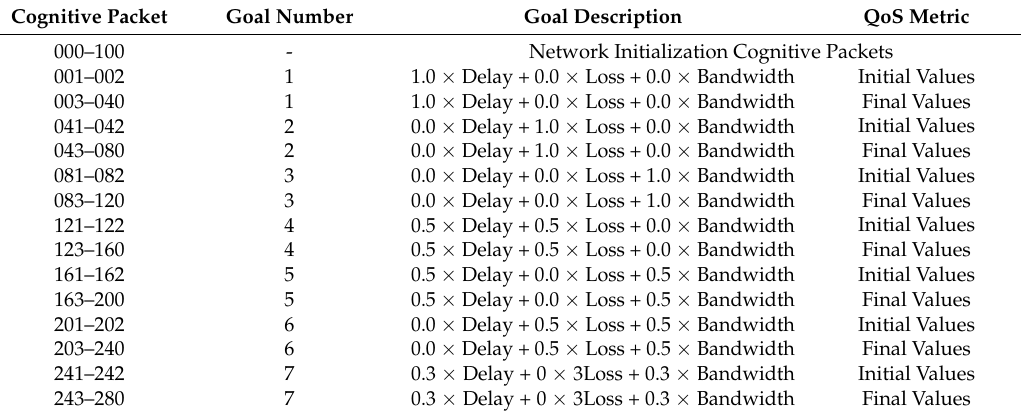
Table 10. QoS Deep Learning Cluster Validation (4 × 4 Nodes) —Simulation Parameters.